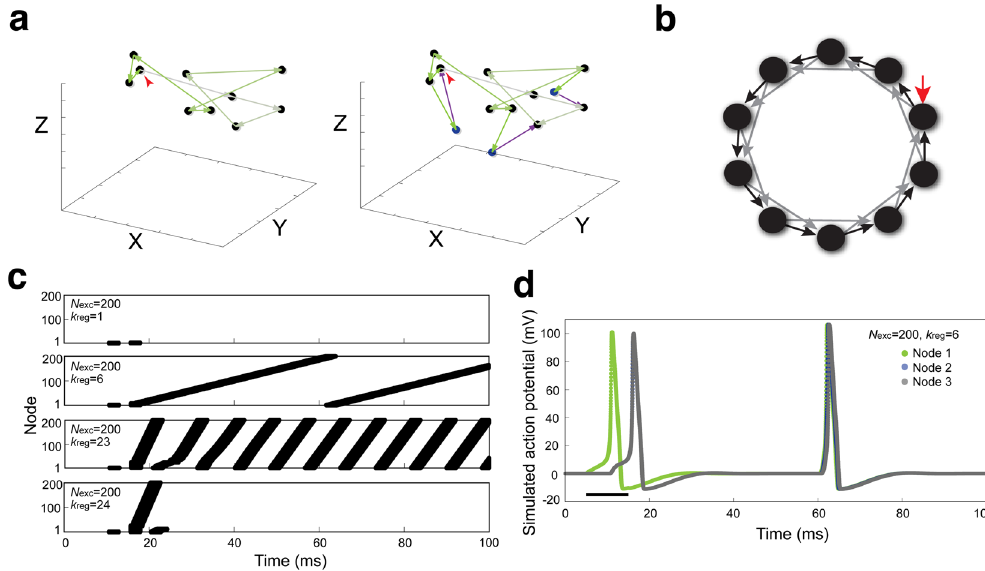
Figure 2. Building a regular circular network for simulating LN network. ( a ) Conceptual illustration of the spatial and temporal dynamics of neuronal activity in an ensemble. Neurons are randomly plotted in a representation of a three-dimensional space. Left : a closed loop network with solely excitatory neurons (black dots). Right : a closed loop network with excitatory (black dots) and inhibitory (blue dots) neurons. The activation flow is demonstrated by green (excitation) or magenta (inhibition) arrows. The darker green arrows represent later events. Red arrows indicate the initial stimulus. ( b ) Diagram of a regular circular network. Nodes (filled circles) represent individual LNs. Synapses from one neuron to the closest and second closest neurons are indicated by black and gray arrows (edges), respectively. The red arrow is a sole stimulus injected to initiate firing. Simulated networks included 200 excitatory nodes ( N exc ) and varying numbers of regular activation edges ( k reg ). For simplicity, only 10 excitatory nodes ( N exc ) and 2 regular activation edges ( k reg ) of each node are shown. ( c ) k reg was varied in a network with N exc = 200. The dynamics of network activation are shown as spike raster plots, with the vertical axis denoting the identity of each node in the network (the node receiving injected stimulus is assigned as node 1) and the horizontal axis denoting simulation time. ( d ) The activation dynamics of individual nodes (node 1, green; node 2, blue; node 3, gray) are shown as simulated action potentials over time in a regular network ( N exc = 200, k reg = 6). Only the first three nodes are shown. The black bar indicates the period of stimulation. Node 2 and node 3 are simultaneously activated by node 1. Consequently, the action potential of node 2 overlaps with node 3 and the two activations are not clearly visible in the